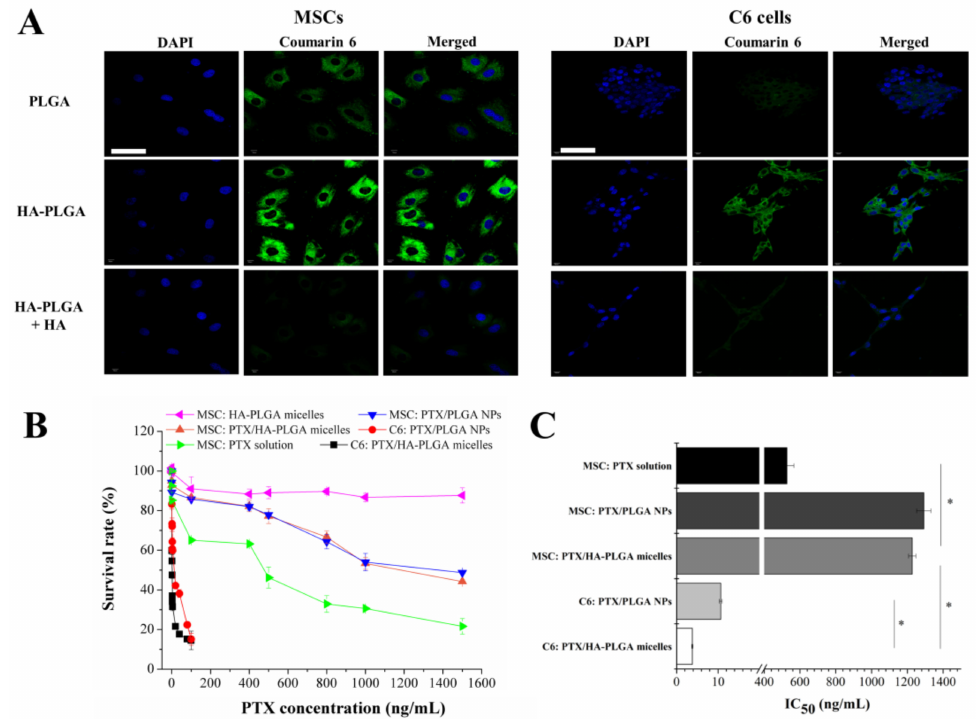
Figure 2. ( A ) Uptake of coumarin 6/PLGA NPs, coumarin 6/HA-PLGA micelles and coumarin 6/HA-PLGA micelles combined with free HA. The nucleus was stained with DAPI (blue) and green represented coumarin 6 (bar = 50 µ m). ( B ) Cytotoxicity of PTX/HA-PLGA micelles, PTX/PLGA NPs, and PTX solution against MSCs and C6 glioma cells. Cell viability was determined by MTT assay after incubation with PTX formulations for 72 h. ( C ) IC 50 values of PTX formulations in MSCs and C6 cells (* p <